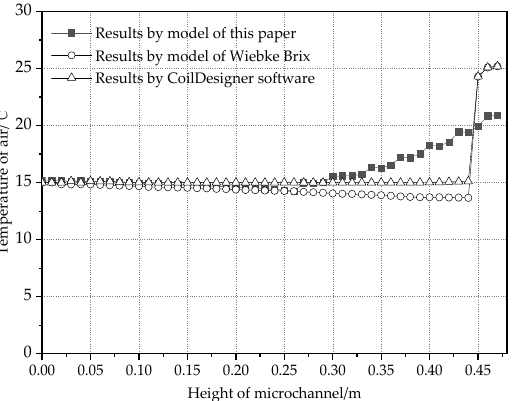
Figure 6. Comparison of the air outlet temperatures along the channel .